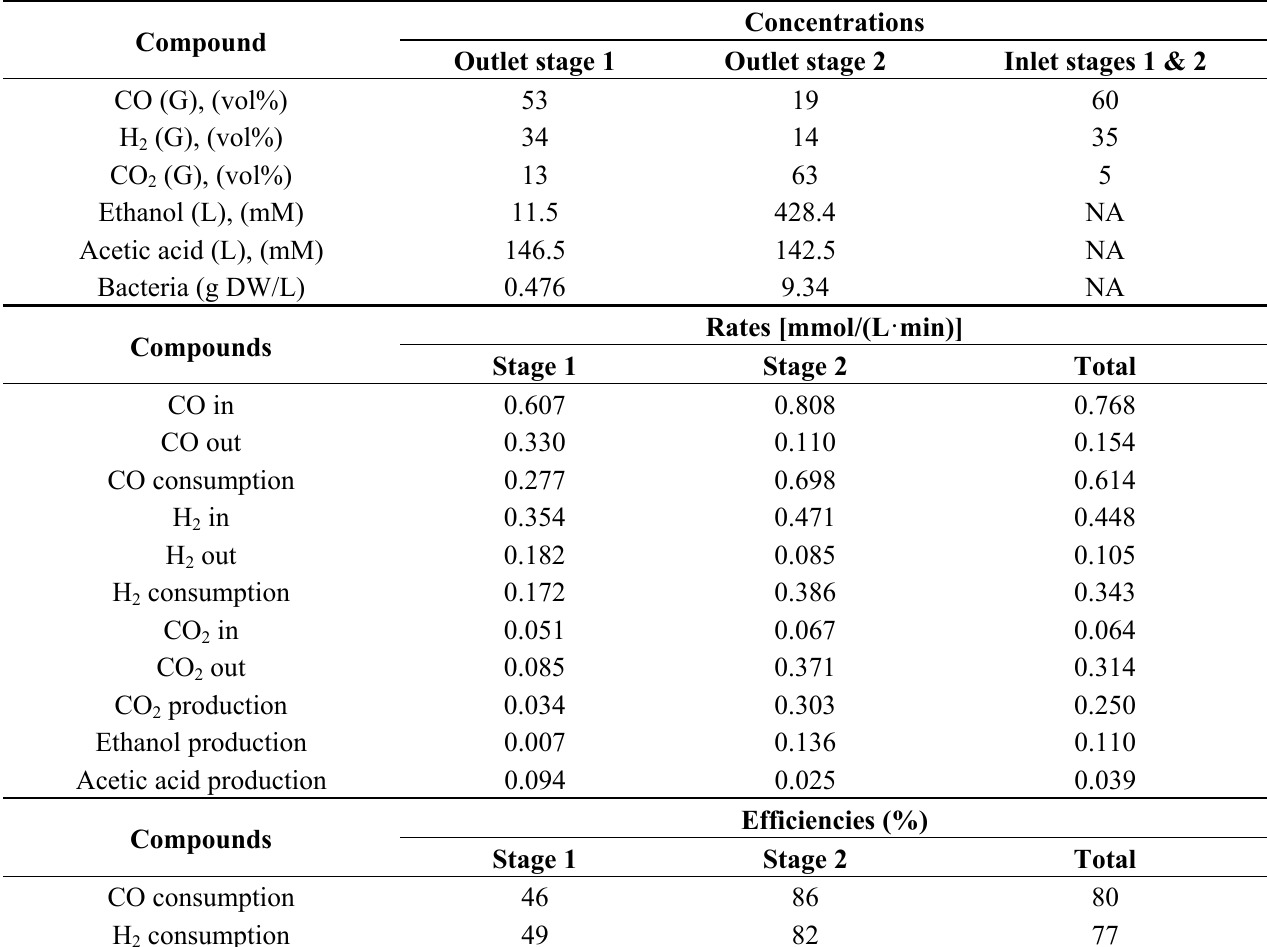
Table 2. Performance parameters of continuous operation of the 2-stage system at time point 1517 h at which stable operating conditions had been achieved. These parameters were used to calculate the fermentation balance explained in the text. The gas inlets for stage 1 and 2 contained the same gas, and are therefore summarized in one